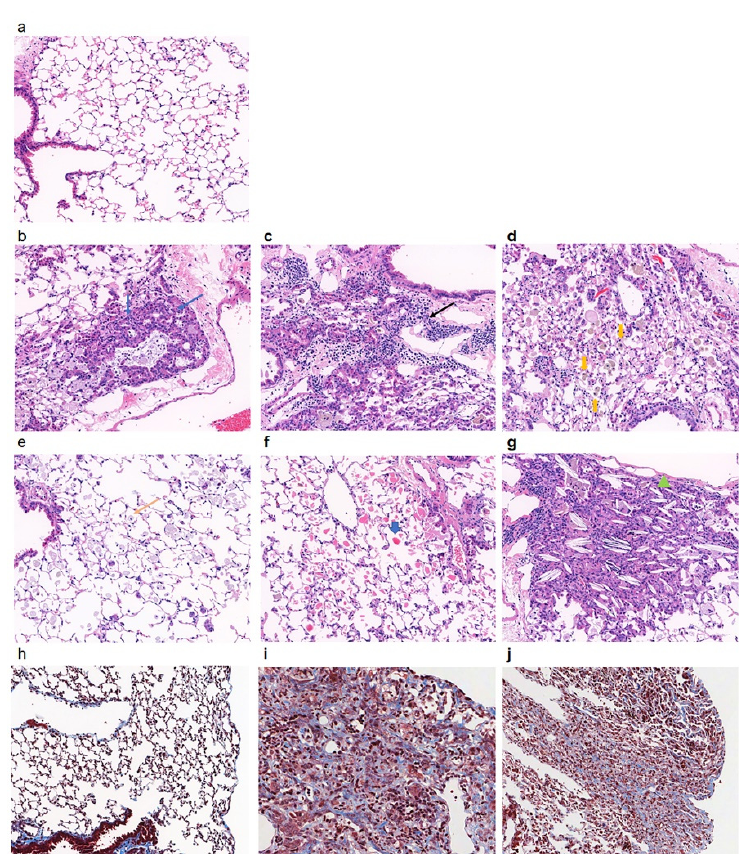
Figure 1. Histopathological analysis of lungs of mice instilled with PHMG ‐ P. Representative histological sections were shown from control ( a , h ) and PHMG ‐ P ‐ treated ( b–g , i–j ) groups. The lung sections were stained with hematoxylin and eosin (H & E, a–g) and Masson’s Trichrome ( h–j ). Blue arrow indicates hyperplasia of epithelial cells ( b ), black arrow indicates lymphocyte infiltration ( c ), yellow thickened arrow indicates pigmented macrophage ( d ), yellow arrow indicates foamy macrophage ( e ), blue thickened arrow indicates proteinaceous substance ( f ) and filled green triangle indicates crystal cleft ( g ) (original magnification, ×